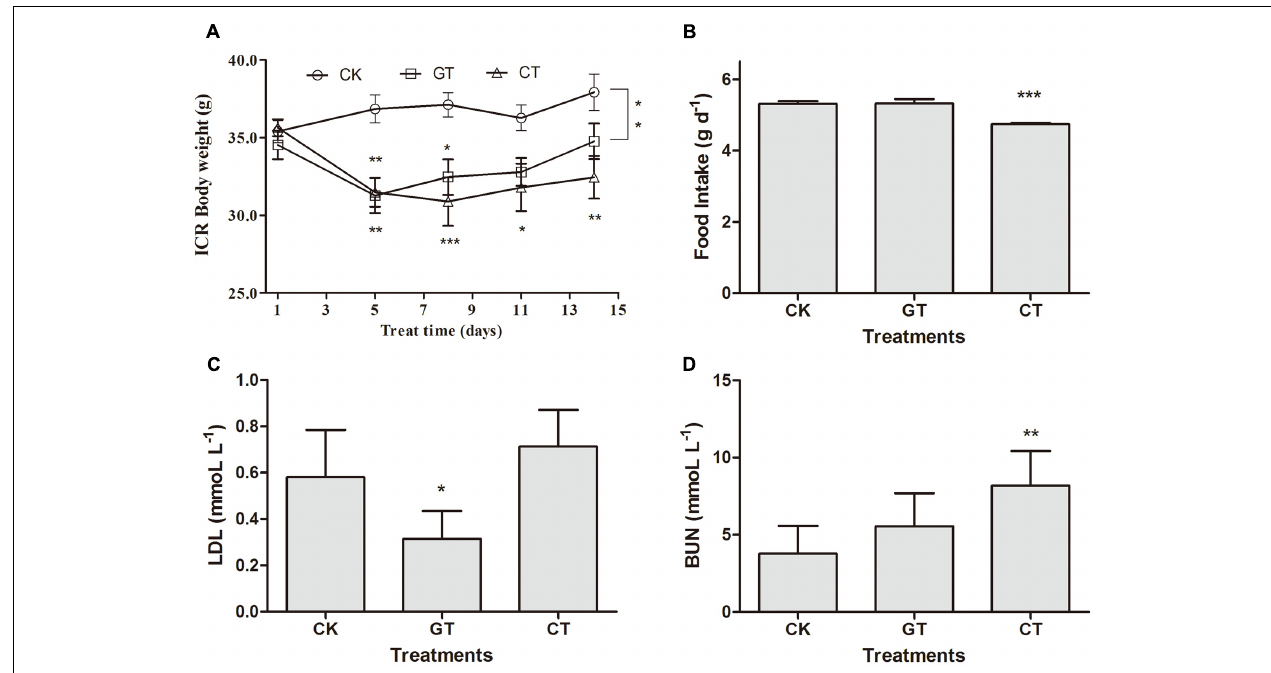
FIGURE 4 | The influence of C. gloeosporioides -contaminated tea on ICR mice. Body weight (A) , food intake (B) , LDL (C) , and BUN (D) values in different groups. Data were compared with CK group. Mean ± SEM. ∗ P < 0.05; ∗∗ P < 0.01; and ∗∗∗ P < 0.001.